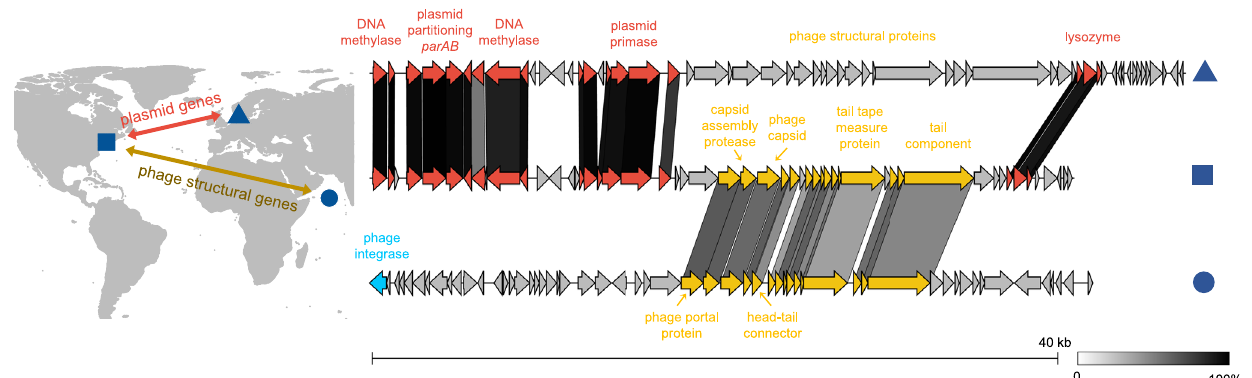
Fig. 4 | The same plasmid backbone carrying different phages genes dis- seminate vast geographic distance. Tritonibacter mobilis M41-2.2, isolated in Denmark, contains a phage-plasmid (triangle) whose plasmid-related genes are homologous and syntenic to those of Tritonibacter mobilis A3R06 phage-plasmid (square).However,theirphagestructuralgenesareverydifferentfromeachother.